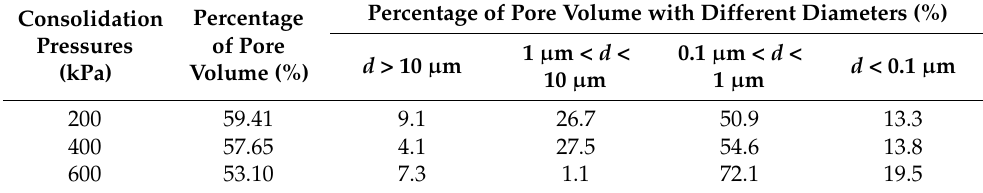
Figure 11. Pore size distribution density function curve of undisturbed Zhanjiang clay under various pressures [38]. Table 5. Pore size distribution in Zhanjiang clay under different consolidation pressures [38].